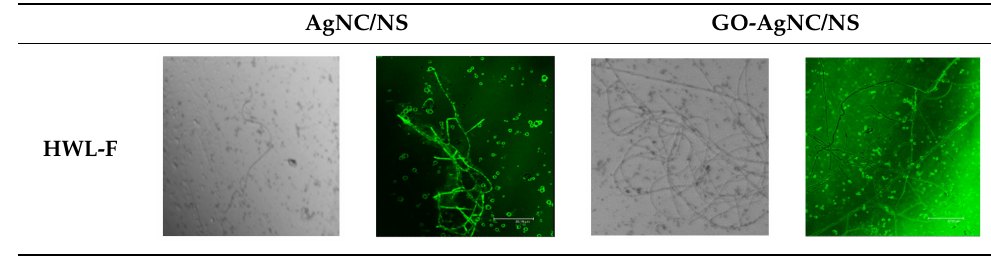
Table 2. Phase contrast and Confocal Laser Scanning Microscopy images of HWL-F adsorbed on AgNC/NS and GO-AgNC/NS